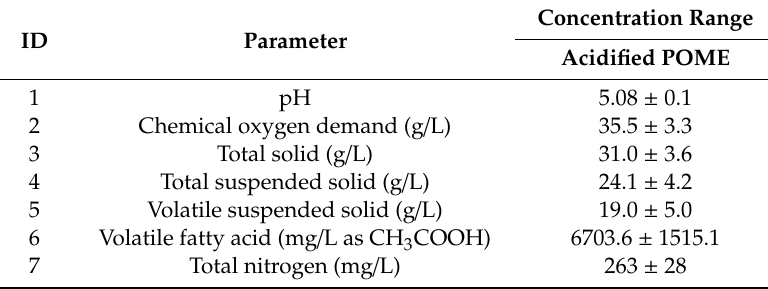
Table 1. Characteristics of the